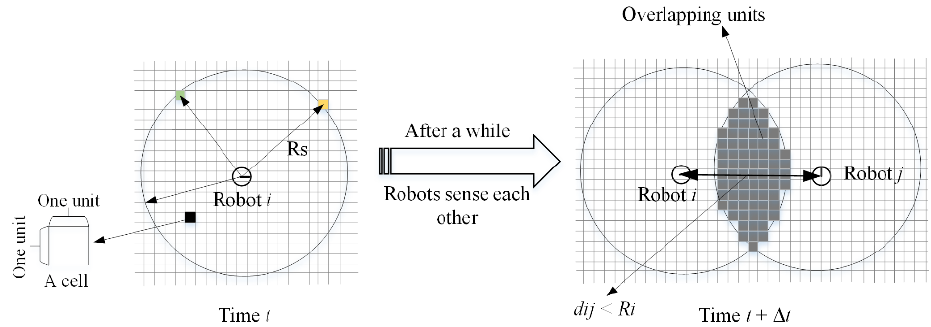
Figure 6. Covered cells and overlapping cells.